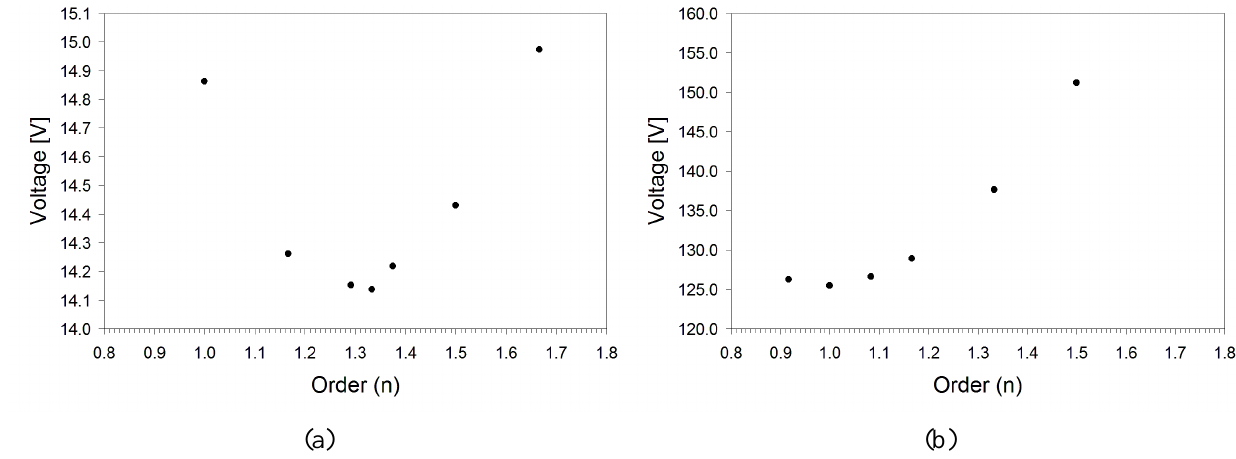
Figure 11. Pull-in voltages for polynomial gap cases (a) cantilever beam (b) fixed-fixed